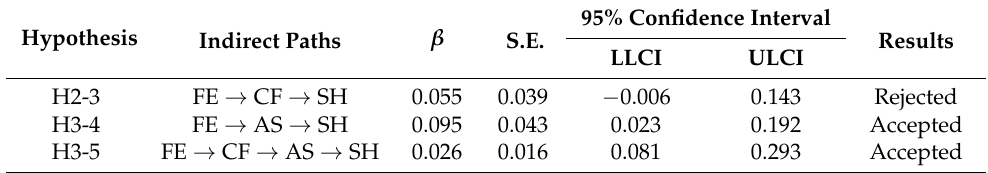
Table 4. Results of multiple mediation effect